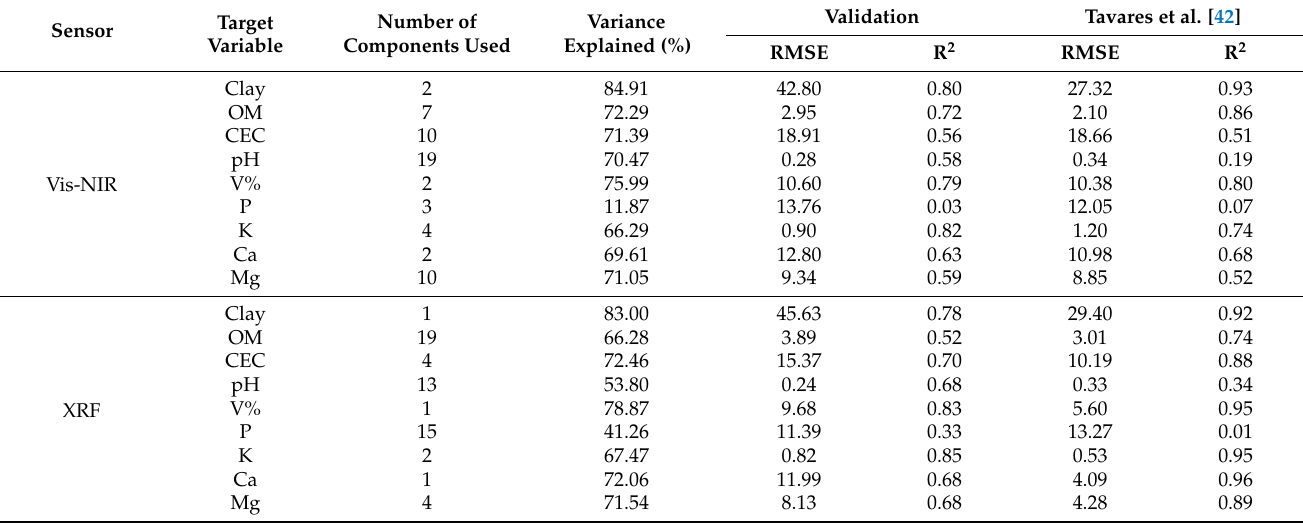
Table 1. Results from the principal component regression (PCR) fitting model applied to the soil physical-chemical attributes